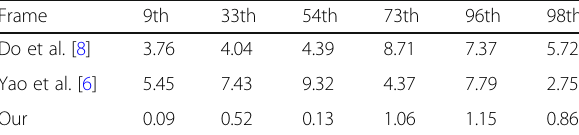
Table 2 Result contrast for “ Ballet ” sequence Method